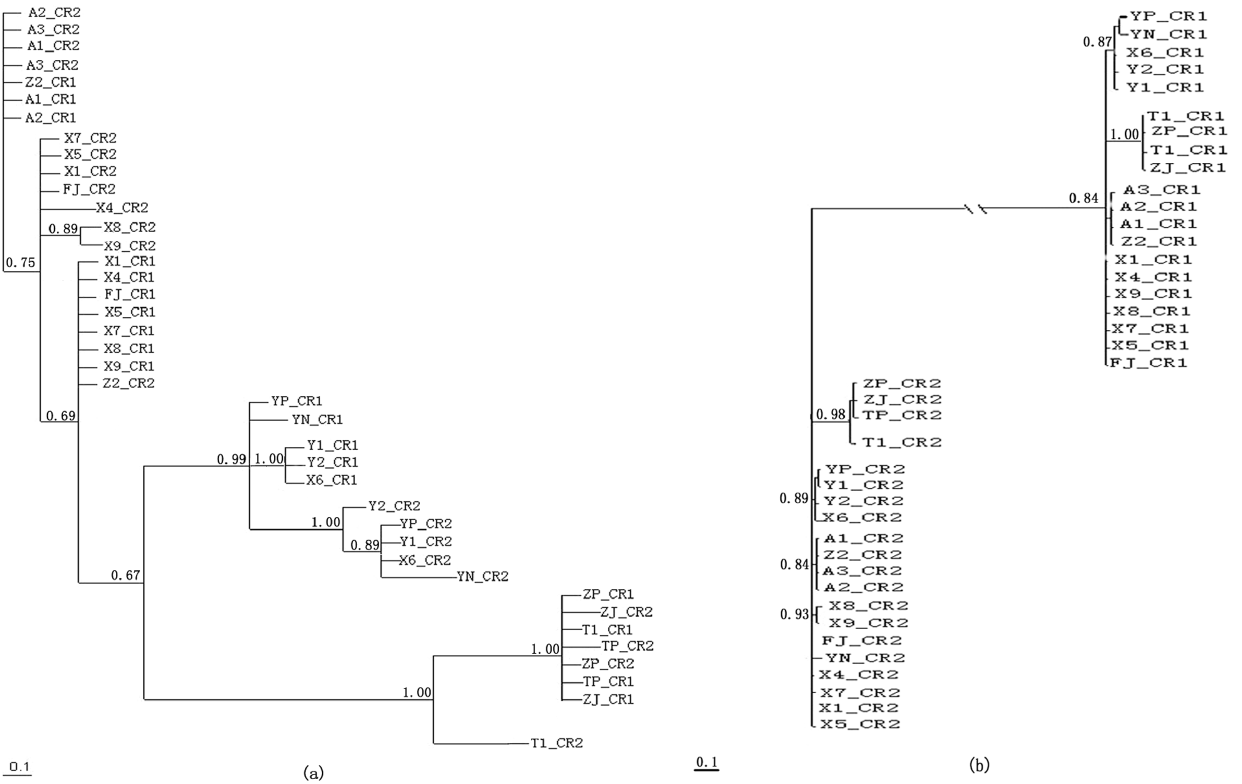
Figure 5. Phylogenetic trees reconstructed using (a) TAS, CD, and CSB domains and (b) VNTRs. All three phylogenetic trees constructed separately based on TAS, CD, and CSB shared similar topology and therefore only one tree is presented here.